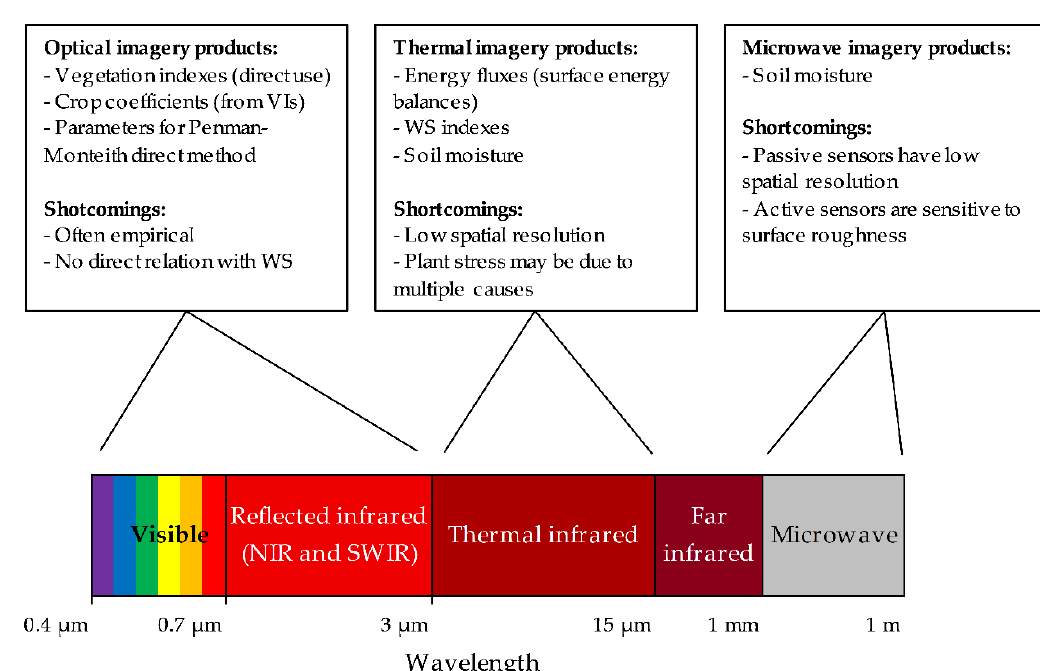
Figure 1. Schematization of the main utilization of remote sensing products by wavelength range, in terms of estimation of crop water stress or of variables related to crop water stress. Major shortcomings are highlighted. NIR: near infrared (from 0.7 to 1 μm circa); SWIR: shortwave infrared (from 1 to 2.5–3 μm circa).